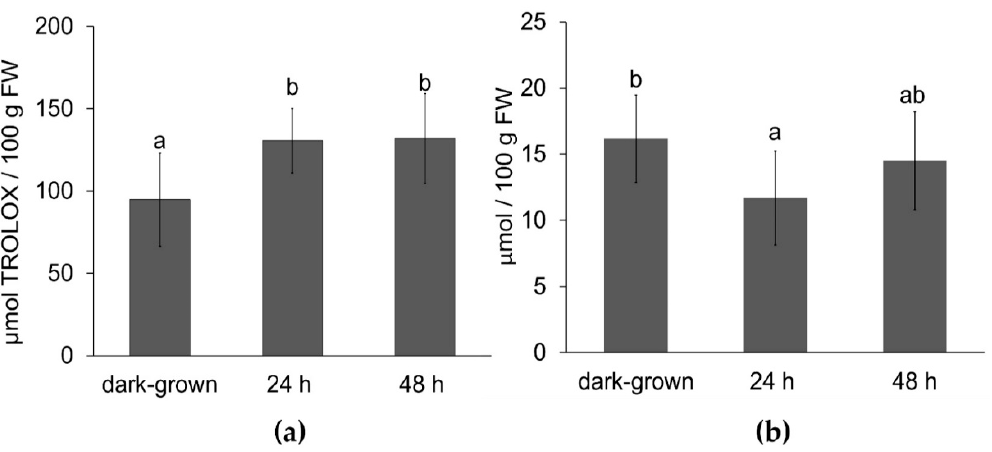
Figure 4. Antioxidant activity in dark-grown chia microgreens and microgreens after exposure to light for 24 and 48 h evaluated by DPPH scavenging activity ( a ) and FRAP assay ( b ). Data represent mean values from three experiments with five replicates (n = 15). The error bars show standard deviation (SD). Different letters signify values that are statistically different at p ≤ 0.05 according to Fisher’s LSD test.